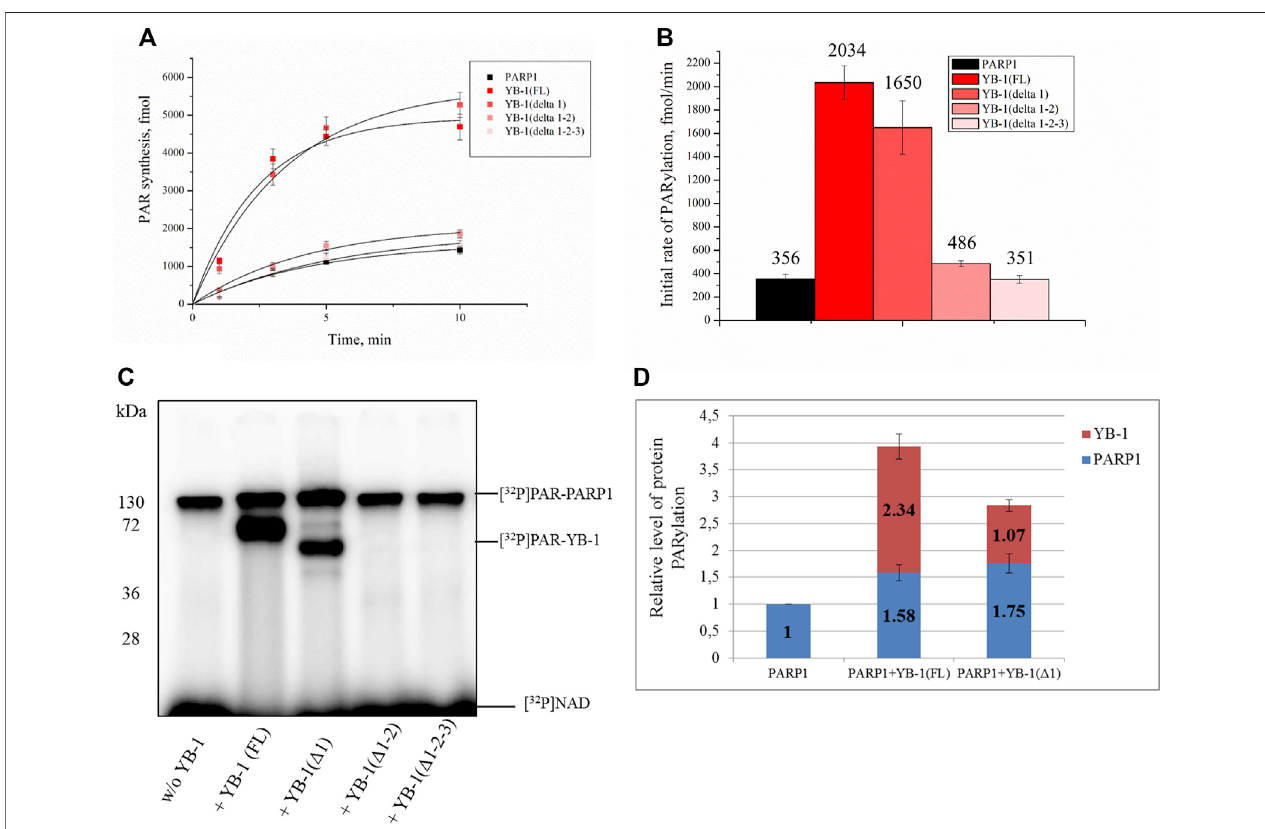
FIGURE 5 | A positively charged region of the YB-1 CTD is required for the stimulation of PARP1 activity and YB-1 trans-PARylation. (A) Kinetics of the PAR synthesis catalyzed by PARP1 in the absence or presence of YB-1(FL) or its deletion mutants. Graphs represent the mean values of three independent experiments witherror barsrepresenting±SD. (B) TheinitialratesofPARsynthesisestimatedin thepresenceofeither YB-1(FL) or oneofitsdeletionmutants.PARP1at100 nM was incubated with 0.5 OD 260 /ml DNA act , 20 μ M NAD + , and [ 32 P]NAD (0.4 μ Ci) in the presence of 2.0 µM YB-1(FL), YB-1 ( Δ 1), YB-1 ( Δ 1-2), or YB-1 ( Δ 1-2-3) as indicated. [ 32 P]PAR-modi fi ed proteins were precipitated with TCA and quanti fi ed radiographically. The initial rates (fmol/min) were determined from a direct analysis of progressive curve (A) which yields P max and k (Equations 1 and 3), and represent the mean ± SD of three independent measurements. (C) PARP1 auto- PARylation and trans-PARylation of YB-1 mutants detected after SDS-PAGE with phosphorimaging. The reaction mixtures contained 100 nM PARP1, 2 μ M YB- 1(FL) or its mutant as indicated, 20 μ M NAD + [ 32 P]NAD (0.4 μ Ci), and 0.5 OD 260 /ml DNA act . (D) The diagram presents relative levels of PARP1 auto-PARylation and YB-1 trans-PARylation (the mean ± SD of three independent experiments). The relative protein PARylation levels were normalized to the auto-PARylation data on PARP1 alone.